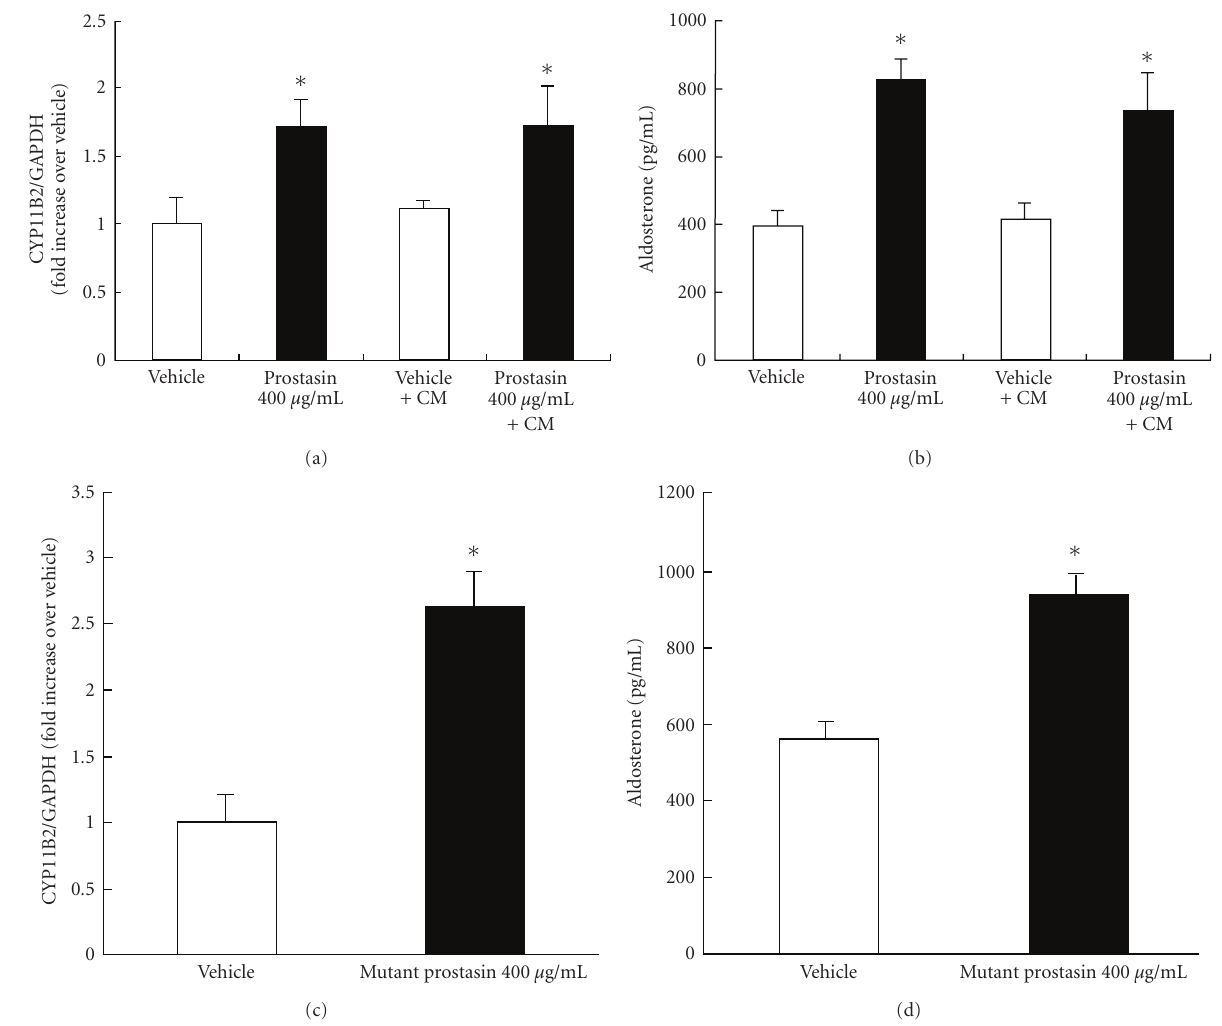
Figure 3: Prostasin increases CYP11B2 expression and aldosterone production independently of its proteolytic activity in H295R cells. (a) CYP11B2 expression was measured following 24-hour treatment with prostasin in the presence or absence of 100 ¯M camostat mesilate (CM). (b) Aldosterone production was determined following 48-hour treatment with prostasin in the presence or absence of 100 ¯M CM. (c) CYP11B2 expression was measured following 24-hour treatment with protease-dead mutant prostasin. (d) Aldosterone production was determined following 48-hour treatment with mutant prostasin. Values are means ± SD ( n = 6). ∗ P < . 001 versus